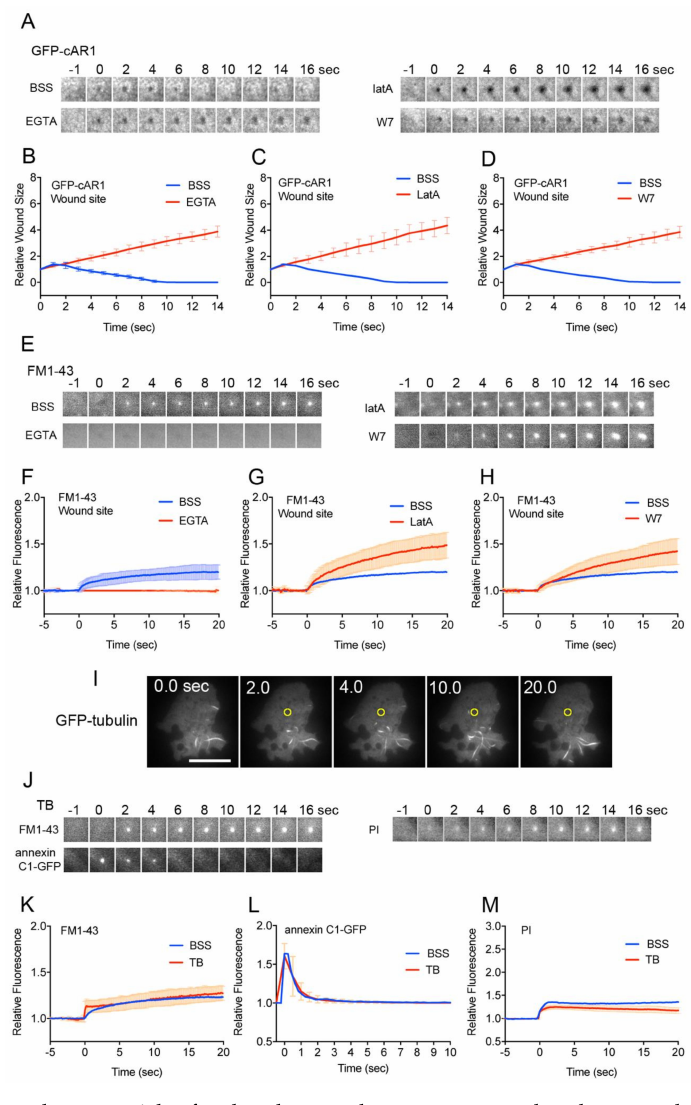
Figure 4. The membrane vesicles for the plug are de novo generated at the wound site. ( A ) Typical sequences of fluorescence image at the wound sites of cells expressing GFP-cAR1 in the presence of BSS, EGTA, latrunculin A, and W7. The wound pore was visualized as a black spot. ( B ) Time courses of the size (diameter) of black spots in the presence and absence of Ca 2 + . ( C ) Time courses of the black spot size in the presence and absence of latrunculin A. ( D ) Time courses of the black spot size in the presence and absence of W7. ( E ) Typical fluorescence images at the wound site in FM1-43 influx experiments in the presence of BSS, EGTA, latrunculin A, and W7, respectively. ( F ) Time courses of the fluorescence intensity of FM1-43 at the wound site in the presence and absence of Ca 2 + . ( G ) Time courses of the fluorescence intensity of FM1-43 at the wound site in the presence and absence of latrunculin A. ( H ) Time courses of the fluorescence intensity of FM1-43 at the wound site in the presence and absence of W7. ( I ) Typical fluorescence images of wounded cells expressing GFP-tubulin. Yellow circles show the wound site. Note that only fragmented images of microtubules were observed under TIRF microscopy. ( J ) Typical sequences of fluorescence image at the wound sites in the presence of TB, a depolymerizer of microtubules; experiments using FM1-43, annexin C1-GFP, and PI, respectively. ( K ) Time courses of the fluorescence intensity of FM1-43 at the wound site in the presence and absence of TB. ( L ) Time courses of the fluorescence intensity of annexin C1-GFP at the wound site in the presence and absence of TB. ( M ) Time courses of the fluorescence intensity of PI at the wound site in the presence and absence of TB. All graphs are shown with average ± SD (n = 25,